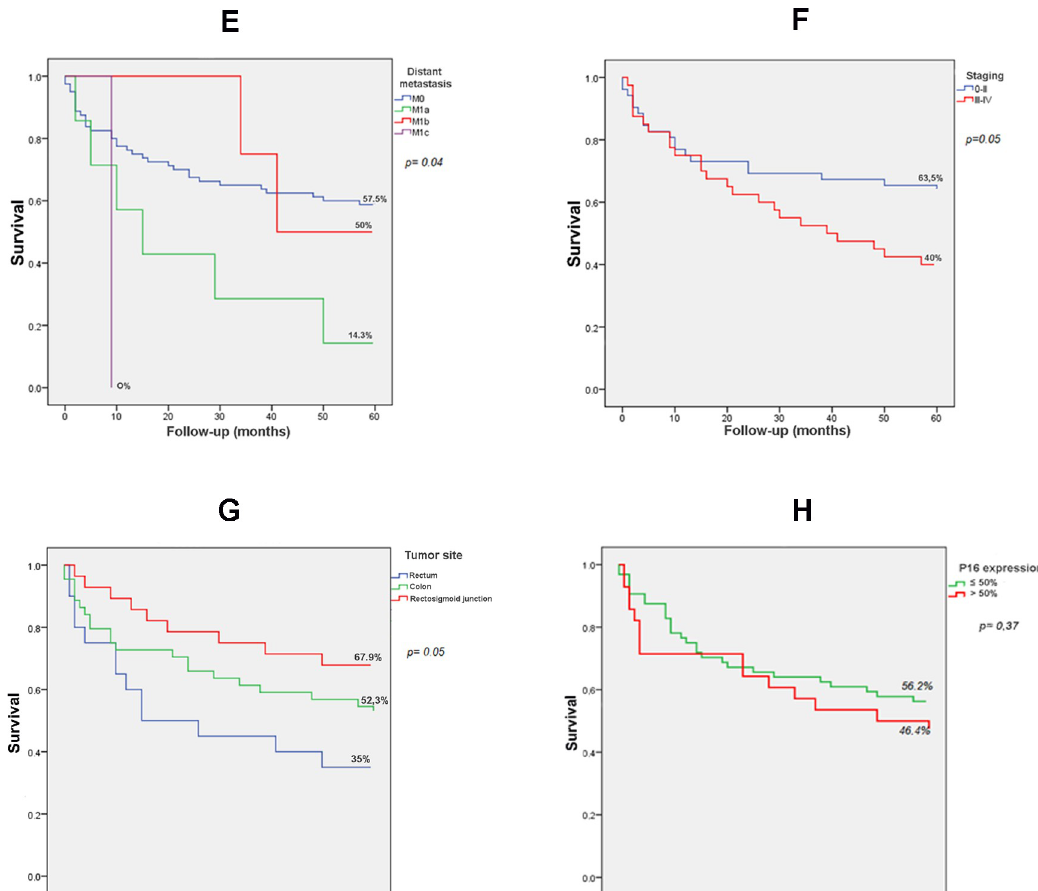
Fig 4. The survival analysis. E. 60-month survival for participants with colorectal cancer in relation to tumor size (Kaplan-Meier method). F. 60-month survival for participants with colorectal cancer in relation to lymph node involvement (Kaplan-Meier method). G. 60-month survival for participants with colorectal cancer in relation to distant metastasis (Kaplan-Meier method). H. 60-month survival for participants with colorectal cancer in relation to tumor staging (Kaplan-Meier